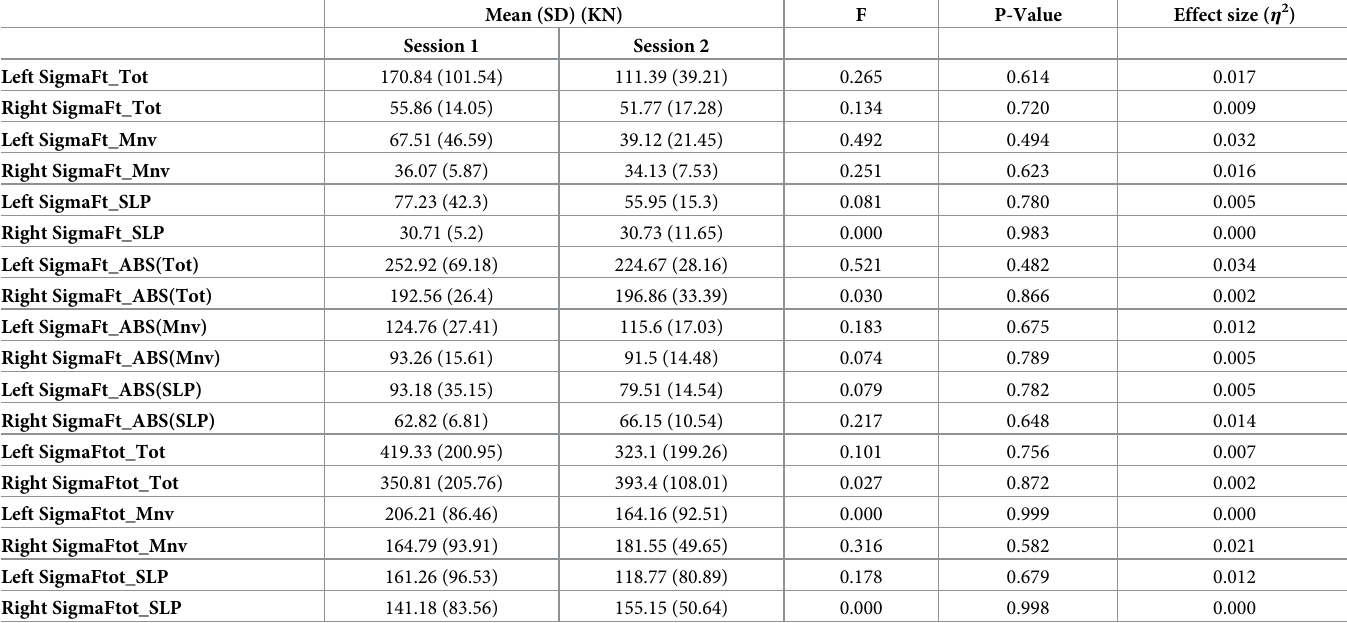
Table 6. Detailed statistical results for push parameters of the left and right wheel.